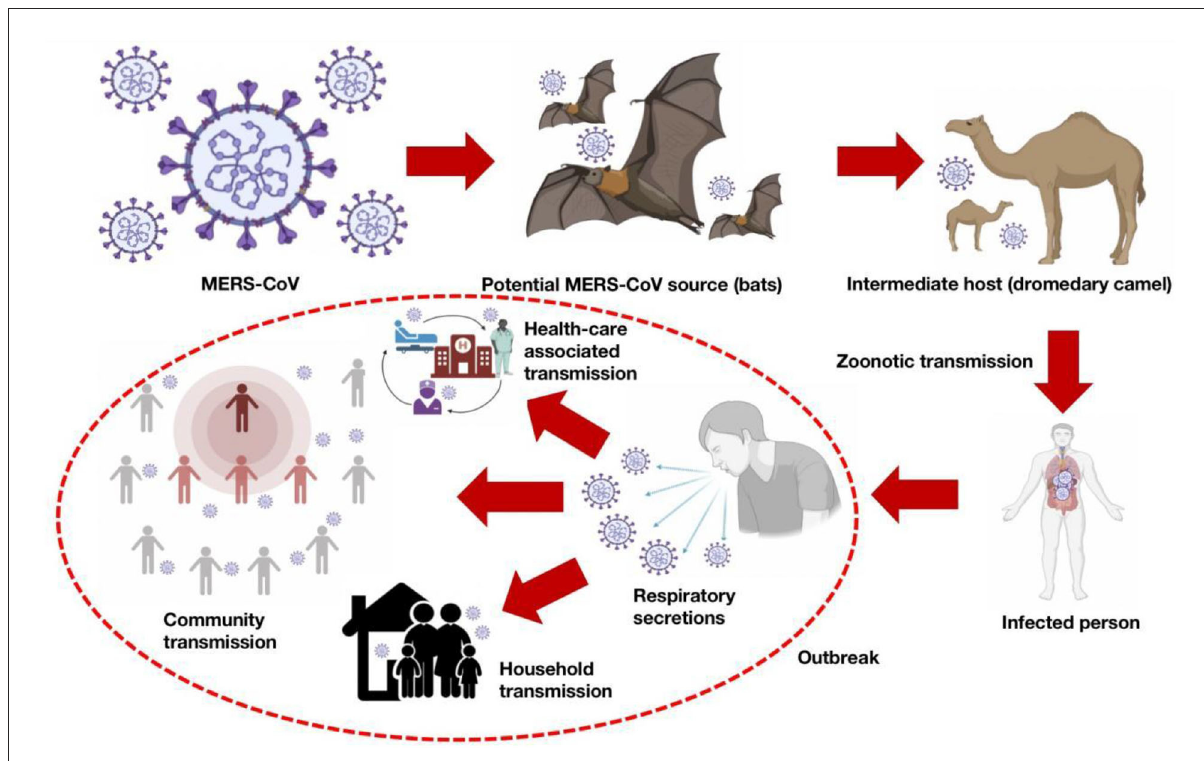
FIGURE1 Potential routes of emergence and transmission of